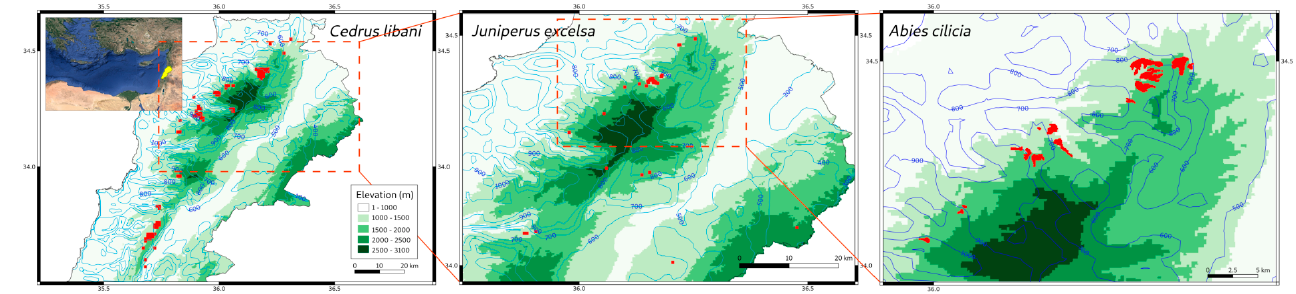
Figure 1. Maps showing current distribution of Abies cilicica , Cedrus libani , and Juniperus excelsa in the mountains of Lebanon with isohyets of current annual precipitation.